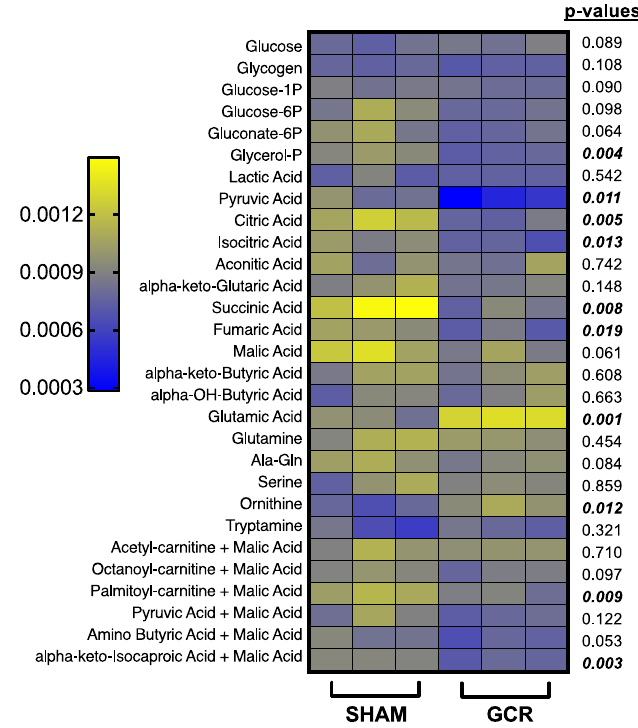
Figure 8. GCR altered the substrate utilization of preOCs in vitro suggesting exposure to high LET IR can result in mitochondrial metabolic reprogramming. Bone marrow macrophages were isolated from 9-month-old male BalbC sham or GCR exposed mice 3 months after the mice were irradiated and cultured in 96-well plates with M-CSF (30 ng/mL) and RANKL (30 ng/mL) for 3 days. Substrate utilization of cells was kinetically determined by transferring multiple NADH and FADH2 producing substrates from Biolog metabolic S-plates. The linear range of the OD590 measurements was used to calculate the changes in color formation in the presence of a redox MC dye using a standard plate reader. (n = 3 per substrate per experiment and the experiment was repeated twice with similar results). Data are presented as ± SD. p values were determined using Student’s t -test between the two groups and listed in the figure for each substrate.